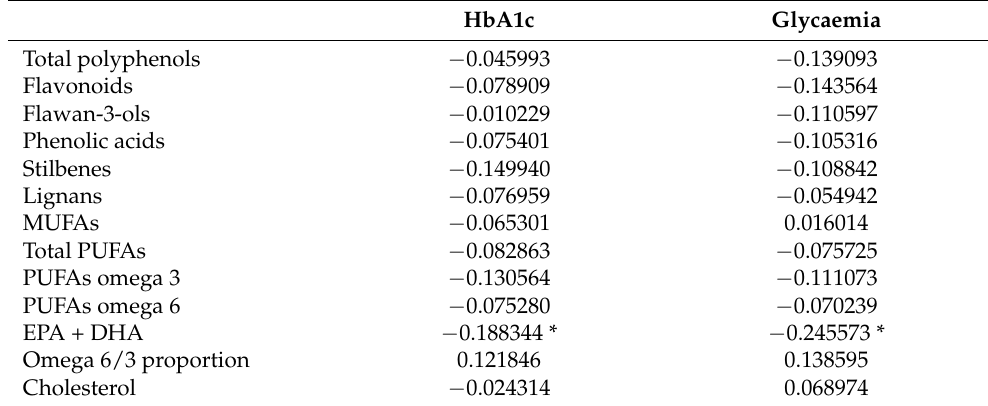
Figure 1. The comparison of glucose concentration between T2DM patients with high and low flavonoid intakes. Data are shown as medians and interquartile ranges (Q1; Q3). The glucose concentration was significantly lower for the high flavonoid intake group ( n = 65) compared to the group characterised by low flavonoid intake ( n = 64), * p < 0.05. Table 4. Correlation coefficients (Rs) for HbA1c or glucose concentration and food components in T2DM patien ts.